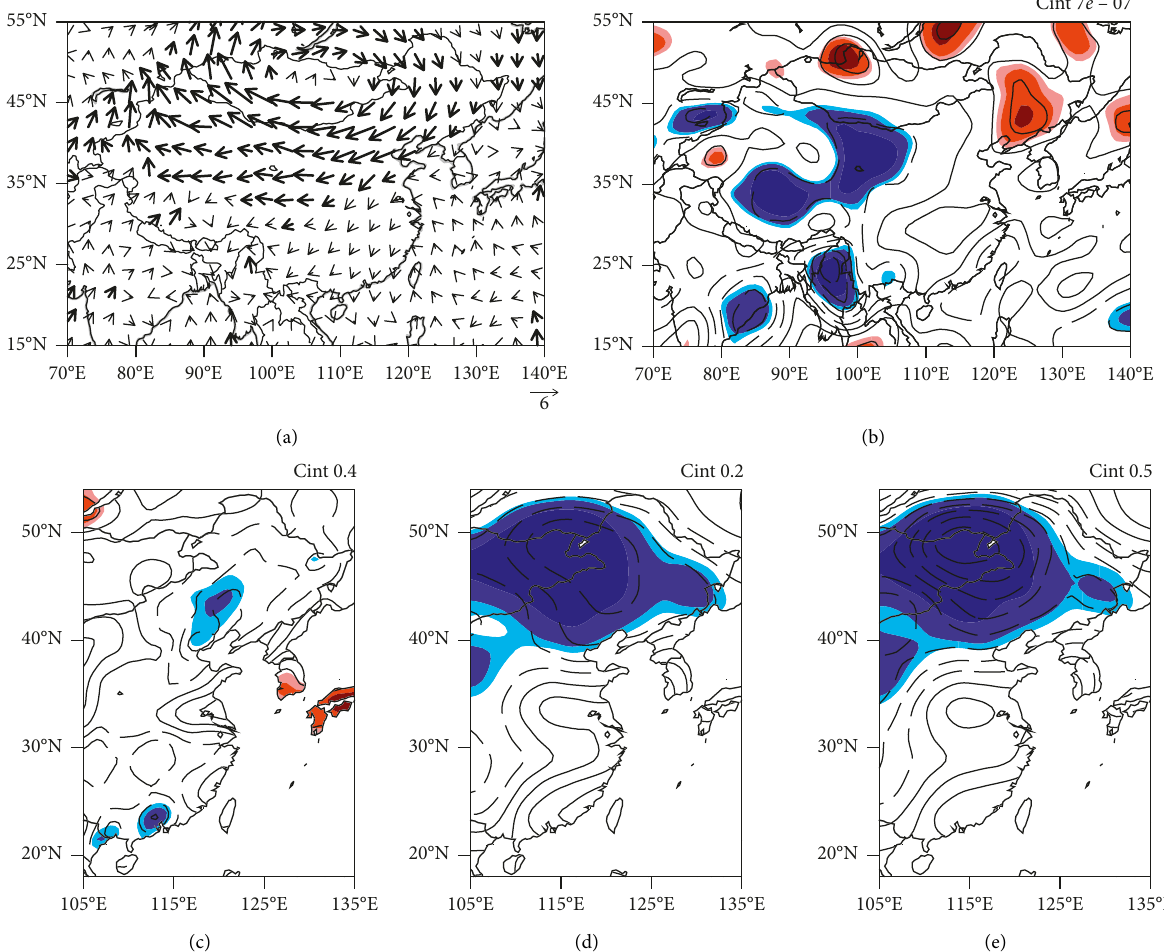
Figure 5: Differences of column-integrated water vapor flux (kg/m/s/hPa) (a) and its divergence (kg/m 2 /s/hPa) (b), total precipitable water (mm/d) (c), precipitation (mm/d) (d), and precipitation efficiency (%) (e) in summer between 1999–2011 and 1983–1998. Thick vectors in (a) denote statistical significance at the 95% level. Solid (dashed) contours denote positive (negative) anomalies, and red (blue) color shadings from light to dark indicate statistical significance at the 90%, 95%, and 99%